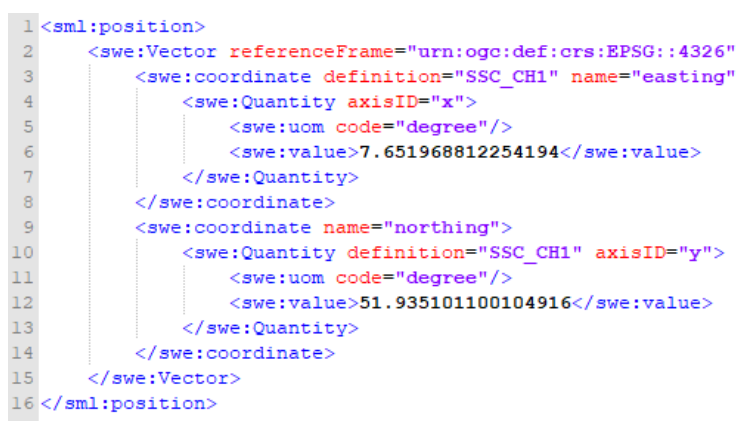
Figure 14. Insert sensor XML request of InsertSensor_position.